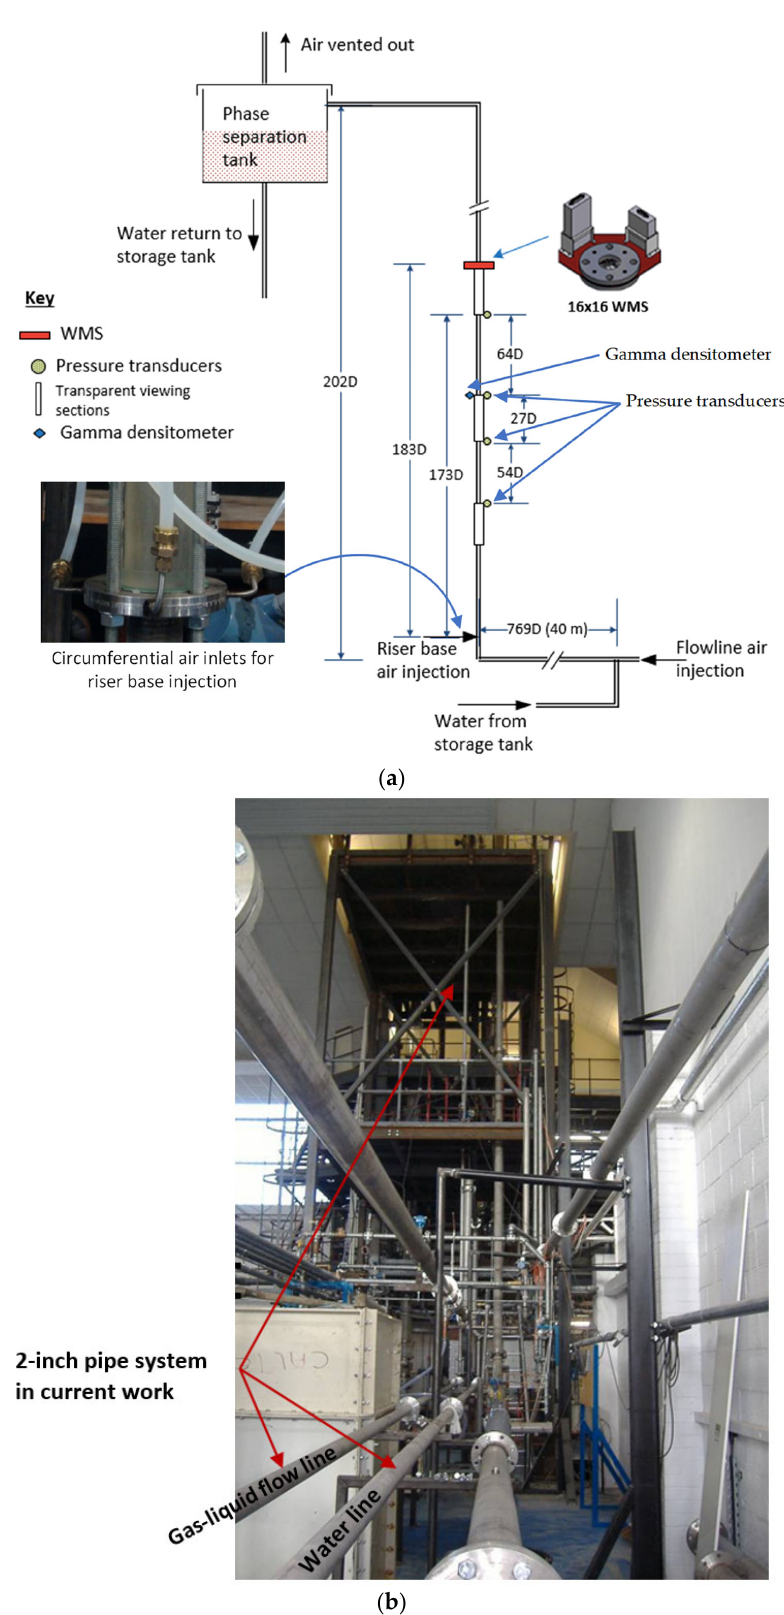
Figure 1. ( a ) Schematic of the test facility at Cranfield University. Images in insets shows the WMS used and circumferential air inlet for the riser base injection. The variable D is the internal pipeline diameter. ( b ) Actual photo of 52 mm experimental facility.